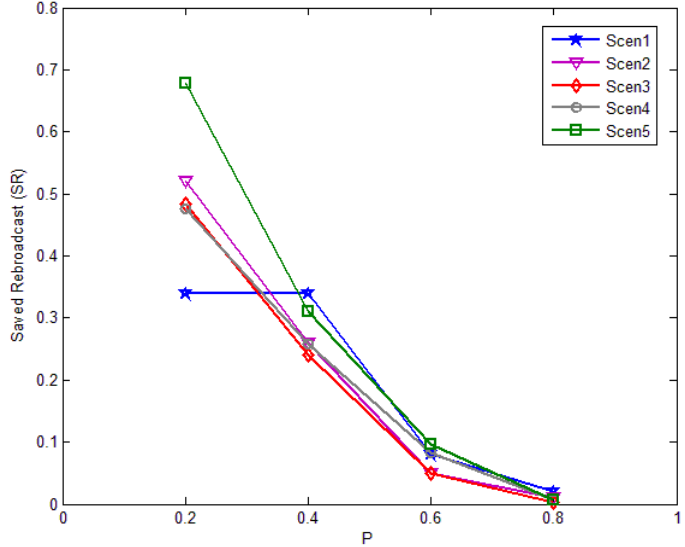
Figure 19. Saved rebroadcast in each scenario against threshold